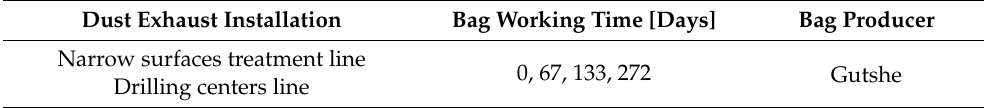
Table 1. Test bags obtained from the furniture factory. Dust Exhaust Installation Bag Working Time [Days] Bag